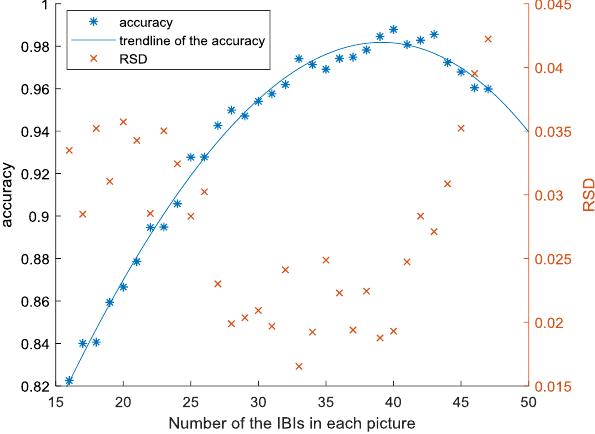
Figure 10. Performance of the CNN model for different data sets created with the pictures of different number of IBIs.